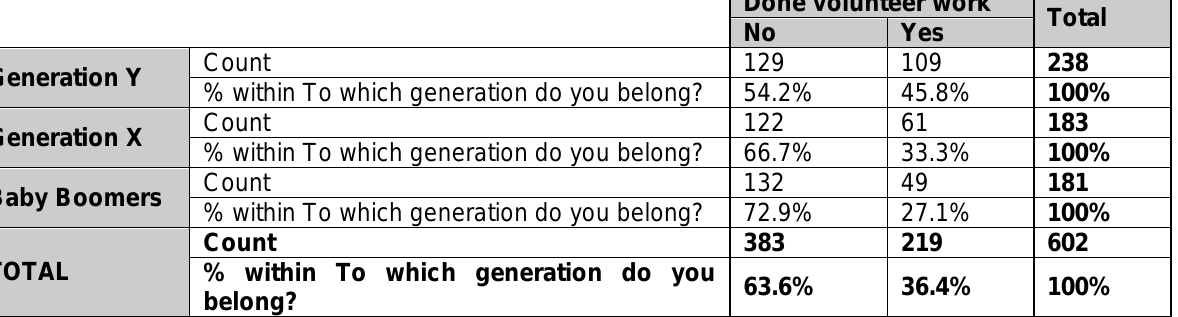
Table 5: Volunteering by different generations Generation